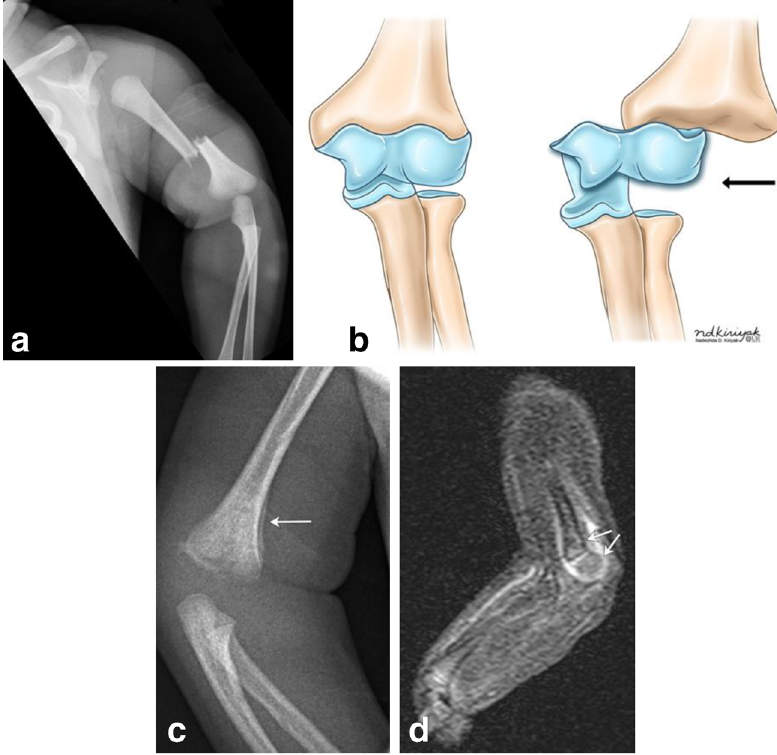
demonstrates fragmentation of the distal right humeral metaphysis, with mild periosteal new bone formation (arrow). Sagittal STIR MR image of the distal right humerus (d) demonstrates increased STIR signal and enhancement surrounding and involving the distal right humeral metaphysis and epiphysis, with mild posterior angulation of the distal epiphysis relative to the metaphysis (arrows), suggestive of distal